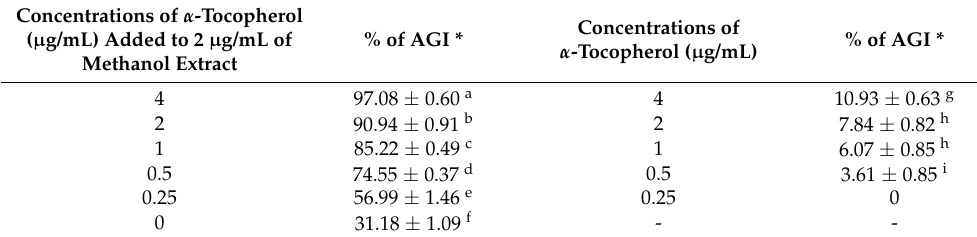
Table 5. Synergistic activity of α